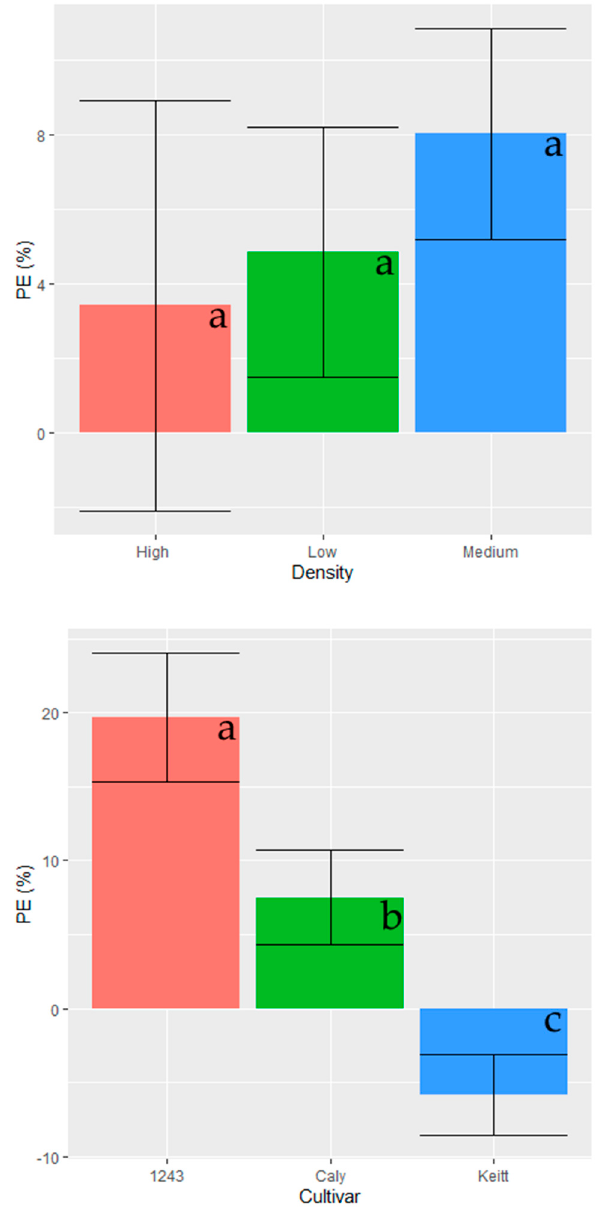
Figure 3. Average percentage error of multi-view count of fruit per tree relative to harvest count, presented by training system for all cultivars and densities (top panel); by tree density, for all cultivars and training systems except trellis (middle panel); and by cultivar, for all densities and training systems except trellis (bottom panel). Bars represent ± SD, significant differences denoted with letters a, b and c to p < 0.05. Associated data is presented in Appendix A.